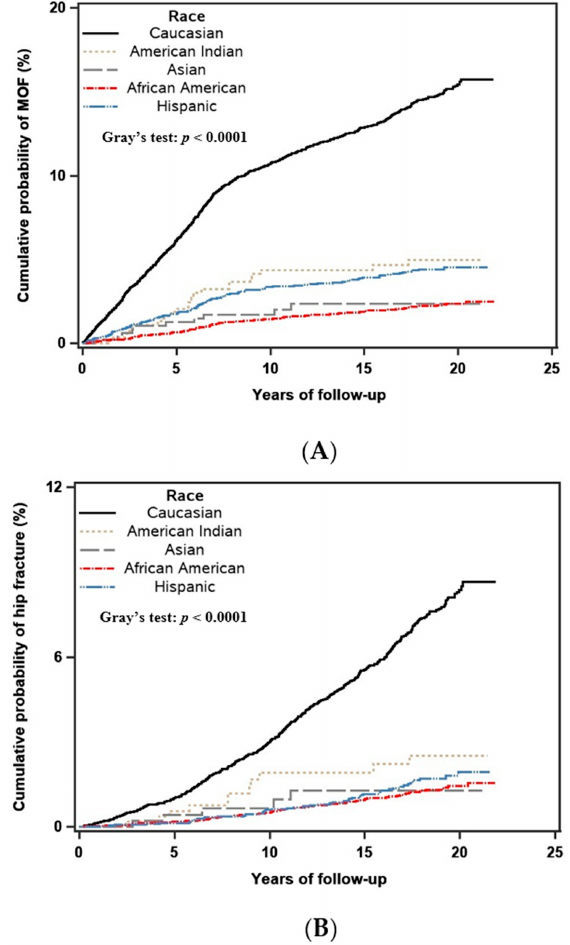
Figure 2. Crude (unadjusted) 10-year cumulative incidence of major osteoporotic ( A ) and hip fracture ( B ) stratified by race, including competing mortality risk. The difference in the cumulative incidence rates among different racial groups was tested by using Gray’s test, with p -value <0.01 indicating a significant difference between the groups. The predicted versus observed 10-year probability of MOF by GRS groups, accounting for competing mortality, are shown in Figure 3A. The 10-year MOF probability derived from FRAX significantly overestimated risk across all GRS groups. The greatest overestimation by FRAX was observed in women who had low GRS, in which the 10-year predicted probability of MOF was 6.02% versus observed 3.74%, with a corresponding predicted/observed ratio (POR) of 1.61 (95% CI, 1.45–1.79), followed by the high GRS group with a POR of 1.38 (95% CI, 1.27–1.50), and in the median GRS group, the POR was 1.40 (95% CI, 1.32–1.49). For hip fracture outcome, the 10-year predicted probability calculated by FRAX overestimated fracture risk in all GRS groups, however, the POR was similar across the three GRS groups (Figure 3B).